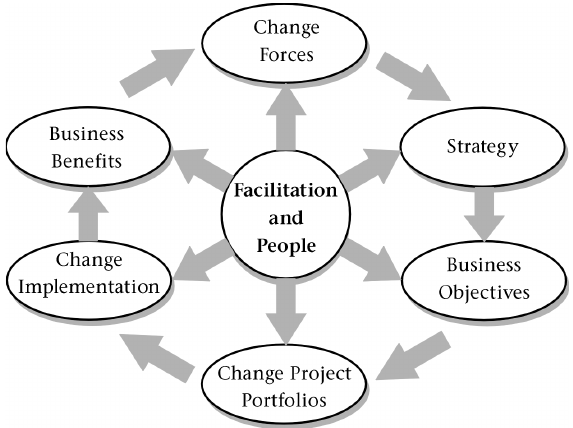
Figure 3: Embedding integrated